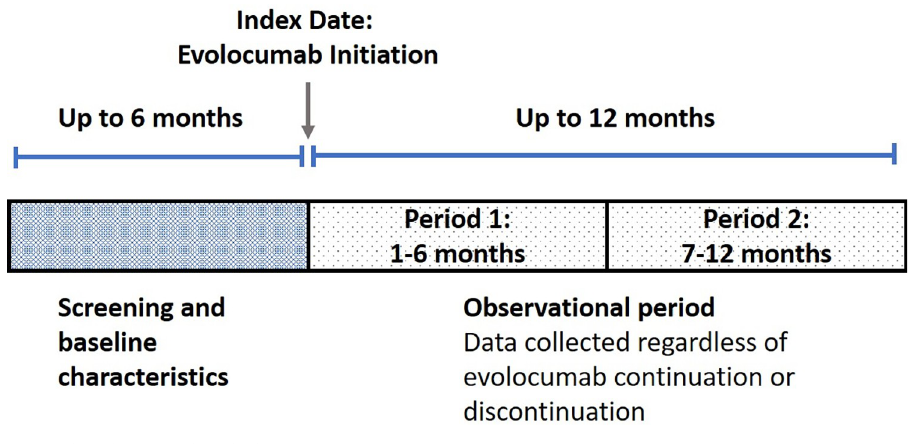
Fig 1. Flow diagram of study